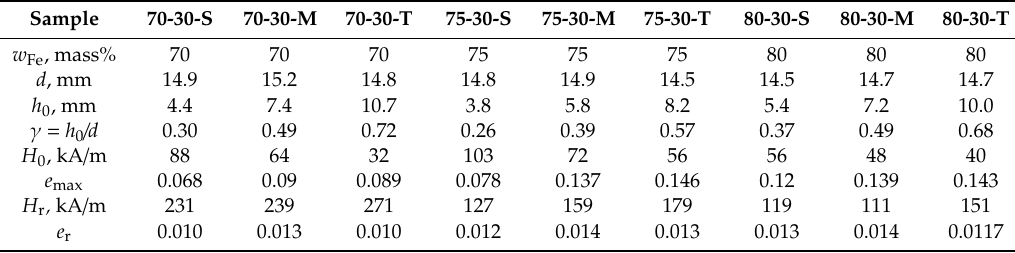
Table 2. Measurement results for MAE samples with the shear modulus of about 30 kPa.